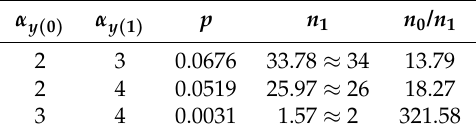
Figure 5. The objective function vs. p at n = 500, α x ( 0 ) = 2, α x ( 1 ) = 4, r f = 100 m , and r c = 500 m . Table 2. The optimum value of p , n 1 , and n 0 / n 1 at n = 500, α x ( 0 ) = 2, α x ( 1 ) = 4, r f = 100 m , and r c = 500 m